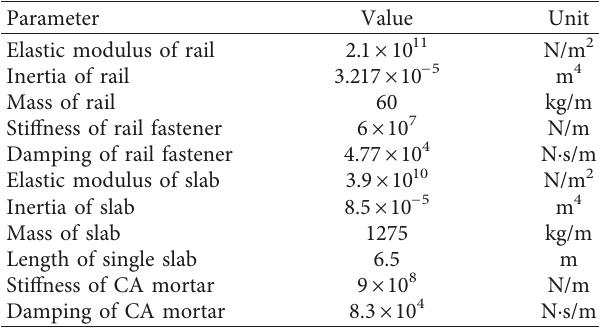
Table 2: Parameters of the CRTS II slab track